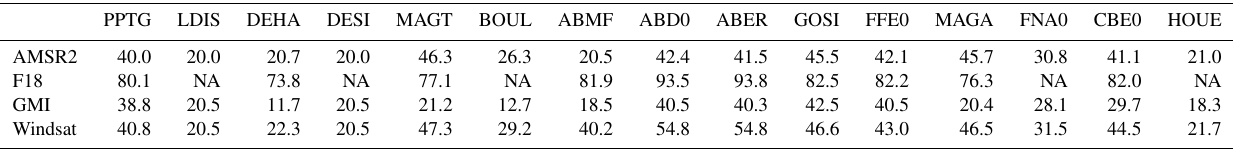
Table 3. Mean distance between GPS stations and the nearest MWR satellite grid-point within the 7 × 7 box surrounding each station (MWR grid resolution 0 . 25 ◦ × 0 . 25 ◦ ). Values are given in kilometres. NA stands for not available.